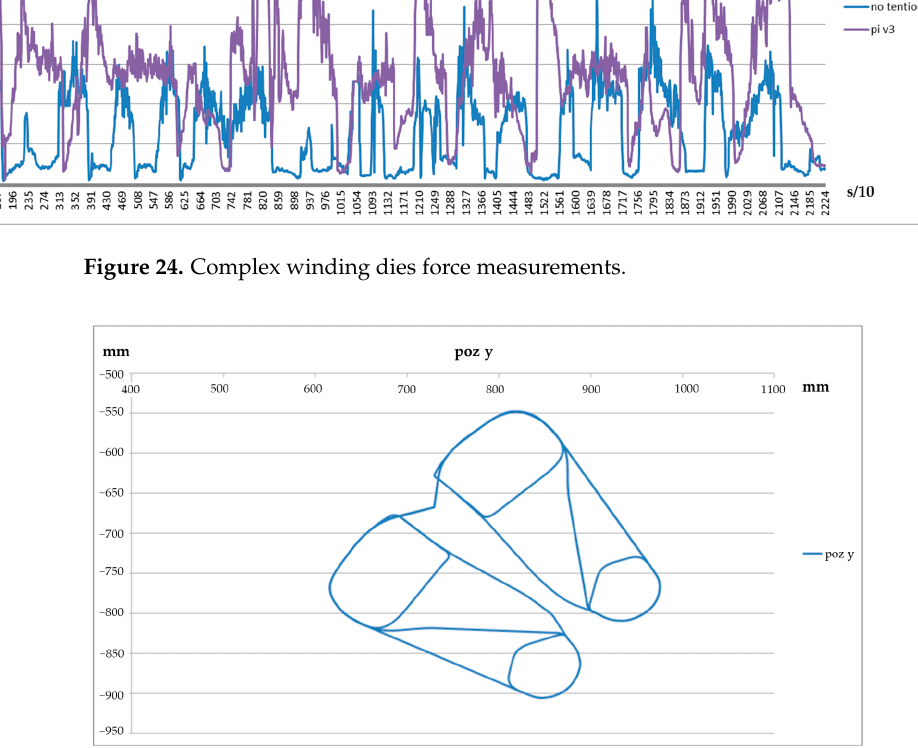
Figure 25. Complex trajectory plan.